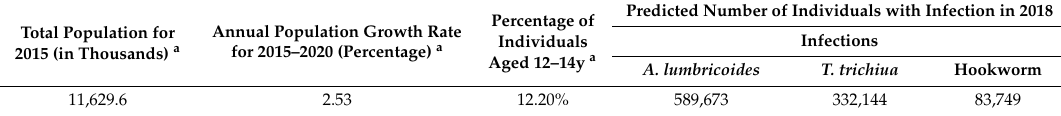
Table 4. Predicted number of individuals aged 12 to 14 years with A. lumbricoides , T. trichiura , and hookworm infection, in Rwanda,